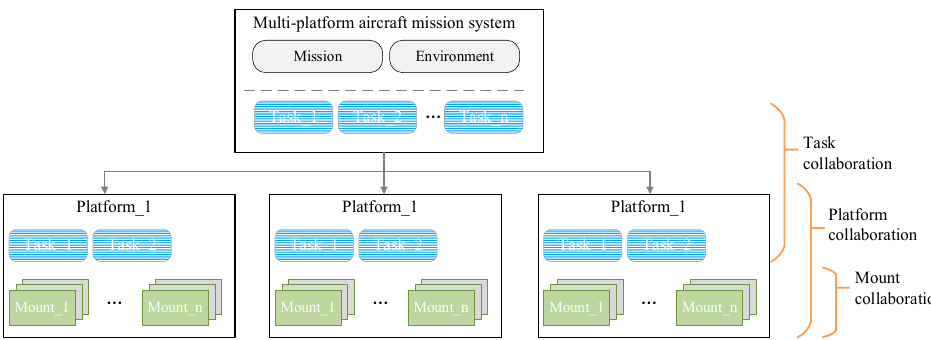
Figure 2. The block diagram of the MPAMS organization.